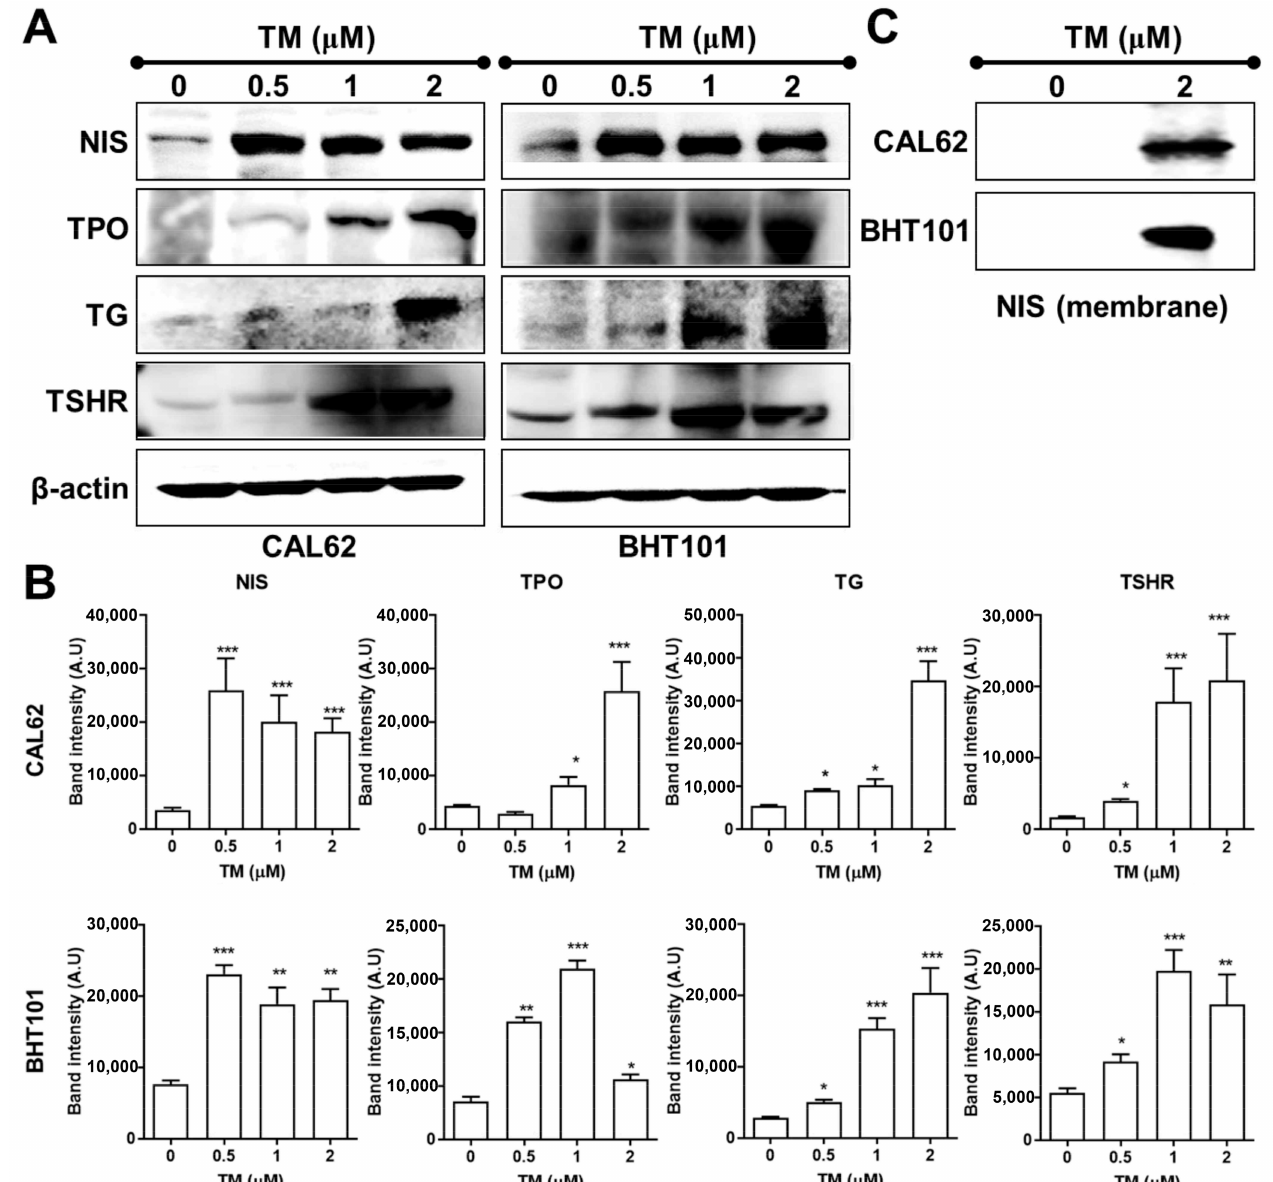
Figure 3. Restoration of iodide-handling genes by tunicamycin (TM). ( A ) Immunoblotting analysis of iodide-handling gene expression in CAL62 and BHT101 cells treated with different doses of TM at 24 h post-treatment. ( B ) Quantitative analysis of respective iodide-handling gene levels by scanning densitometry. ( C ) Immunoblotting analysis of membrane NIS protein levels in CAL62 and BHT101 cells treated with 2 µ M TM at 24 h post-treatment. The membrane fraction was collected by previously described biotinylation-mediated cell surface protein isolation methods. * p < 0.05, ** p < 0.005, *** p < 0.0005, compared to absence of TM. Data are the mean ± SD of three samples per